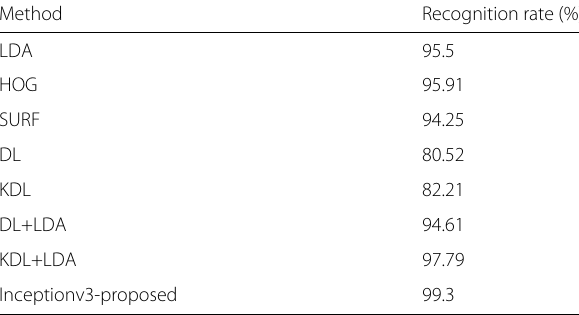
Table 2 Comparison of performance on object categorization on 4-classes